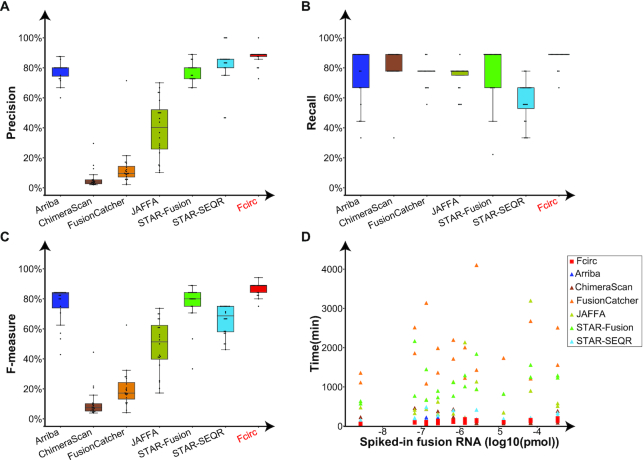
Performance comparison of different gene fusion detection tools in synthetic spike-in actual RNA-Seq data. Comparison of precision (A), recall (B), F-measure (C), and computing time (D) across 7 fusion detection tools, including Arriba, ChimeraScan, FusionCatcher, JAFFA, STAR-Fusion, STAR-SEQR, and Fcirc. In Fig. 2A-C, the black lines in the box (from top to bottom) represent upper quartile, median and lower quartile, respectively; the top and bottom black line represent upper extreme and lower extreme, respectively; the black dots represent data points.